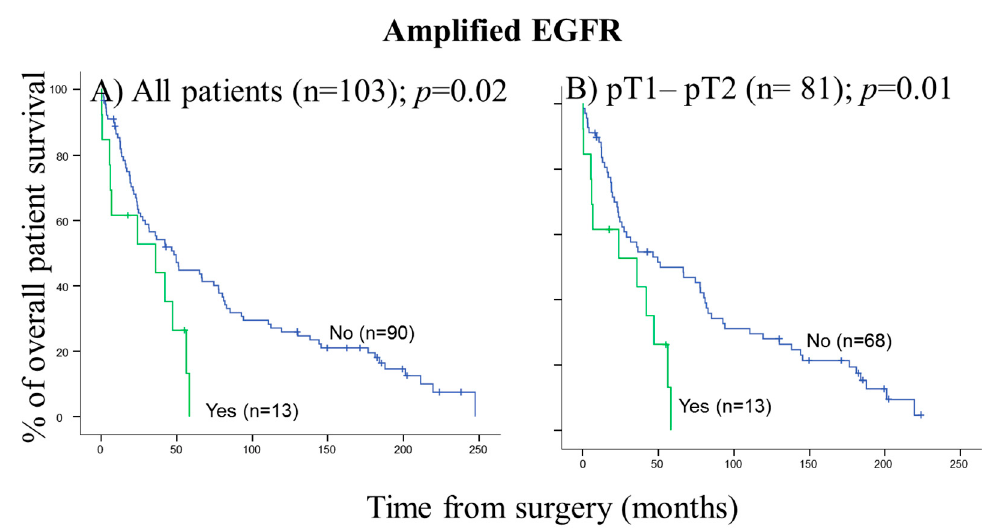
Figure 3. Clinic, histopathologic and biologic-disease characteristics of pulmonary SCC patients which showed a significant impact on overall survival in the univariate analysis: ( A ) Age, ( B ) lymph node status, ( C ) presence of distant metastasis and ( D ) pleural invasion. Survival information was available for 103 cases.